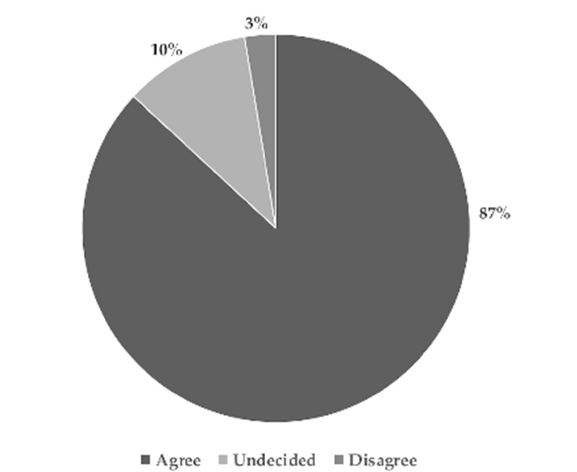
Figure 11. Students’ opinions on the consideration of their learning style for the design of learning activities.